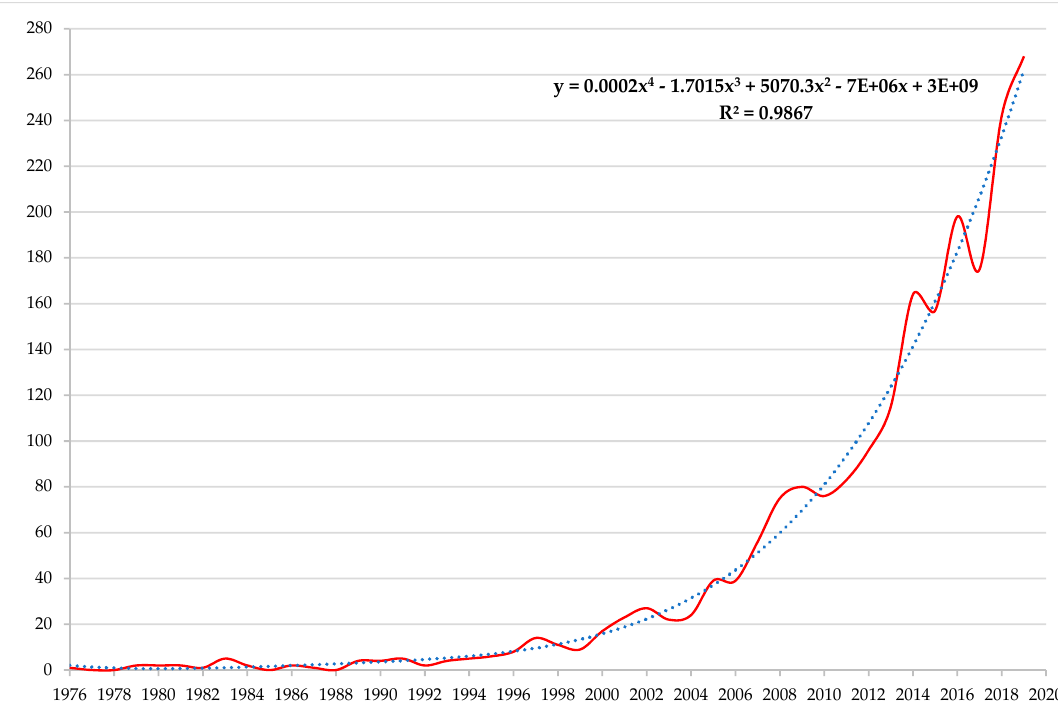
Figure 2. Evolution of Scientific Production. Number of articles per year (1976–2019).